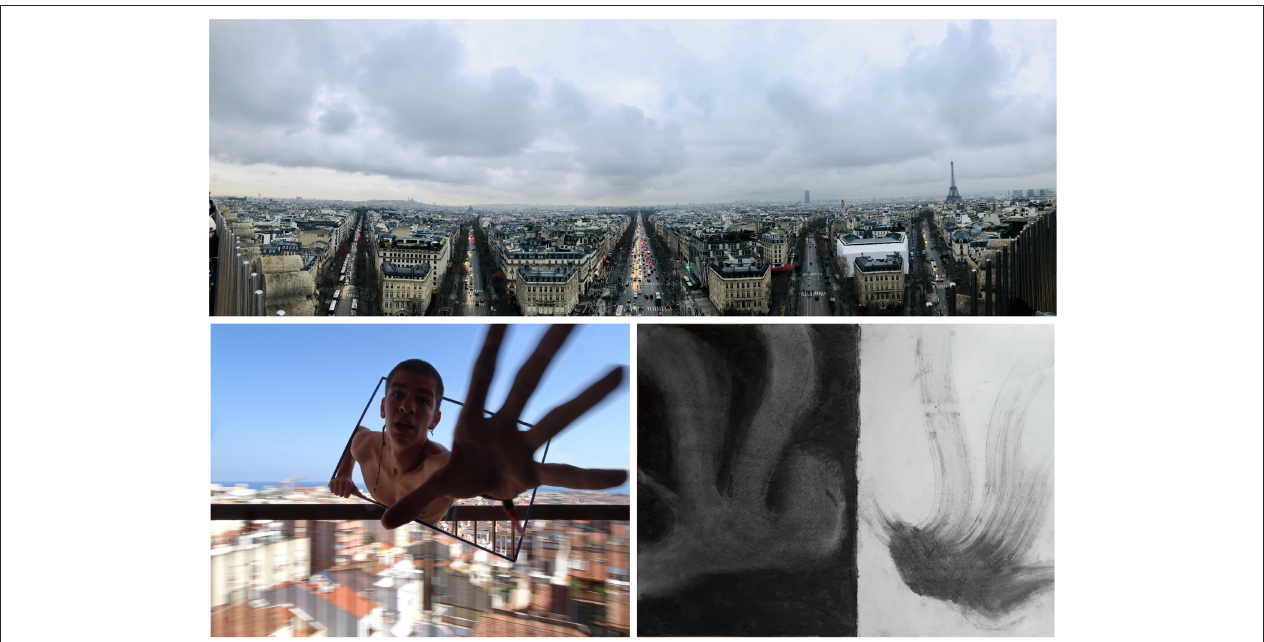
FIGURE 3 | Little artworks. Student’s photographs analyzed in the class. Upper: “Paris” (James Dunlea, USA, 2019). The photograph has paradoxical vanishing lines corresponding to multiple viewpoints with strong perspectival cues. A mixed sense of reality and the impossible. It also generates various symmetry axes and plays with object categorization. Lower left: “Take me out” (Oriol Buscà, Barcelona 2018). This is a composition where foveal/peripheral vision is exploited, along with a strong foreshadowing which gives a particular sense of depth and movement. Lower right: Elisabet Besearan, Barcelona 2019, who plays only with luminance forcing peripheral vision. It appeals for abstract object recognition and for both simple and false symmetry. Oriol Buscà has given the written informed consent to appear in this